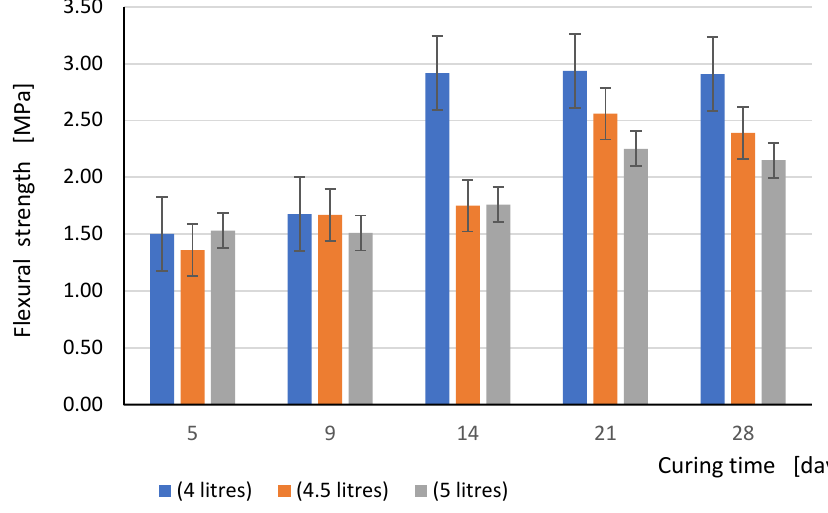
Figure 5. Flexural strength in dependence with the curing time (days) for all tested series.